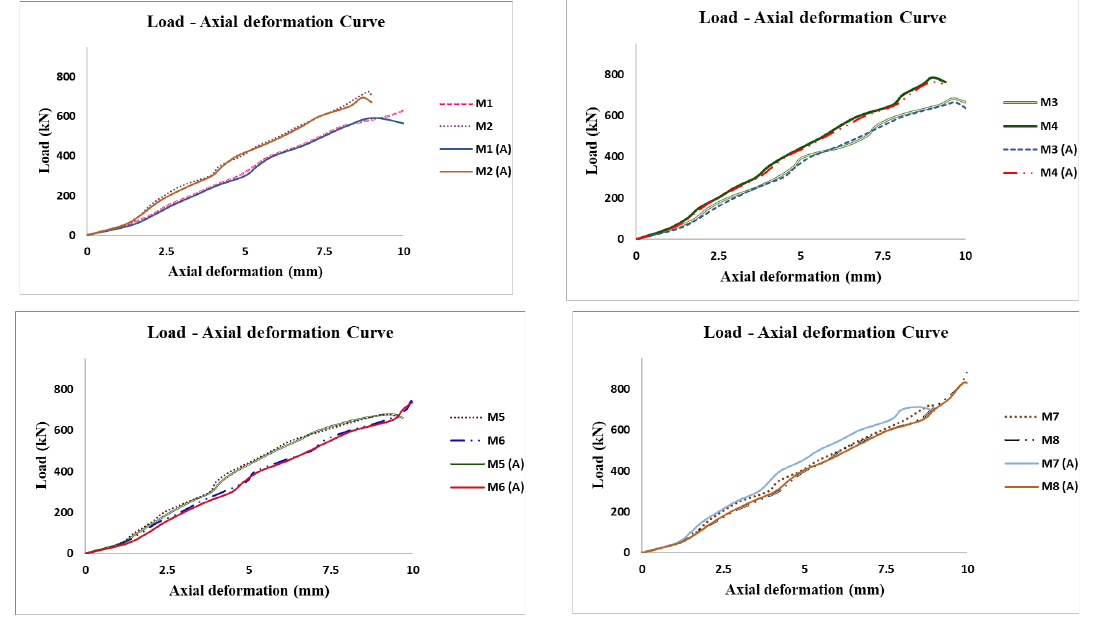
Figure 15. Load vs. axial deformation curves of self-stressed columns for the impact of D / t ratio.